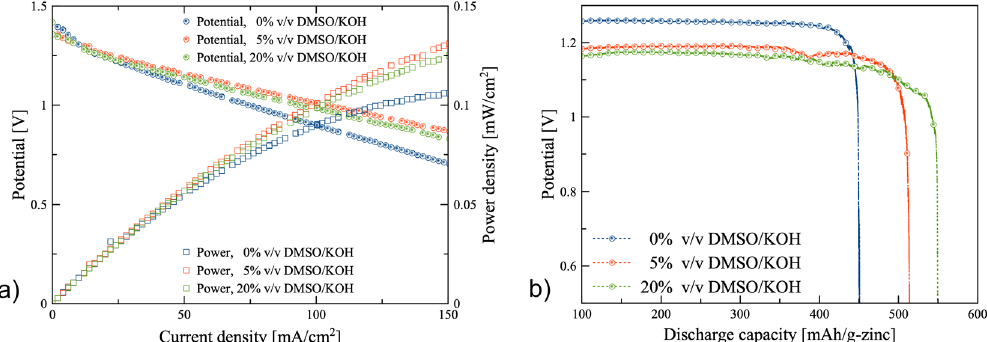
Figure 5. Performance of the zinc-air flow batteries: ( a ) polarization characteristics of the batteries using different electrolytes with the electrolyte circulation rate of 100 mL/min, and ( b ) galvanostatic discharge profiles of the batteries using different electrolytes with the electrolyte circulation rate of 100 mL/min.